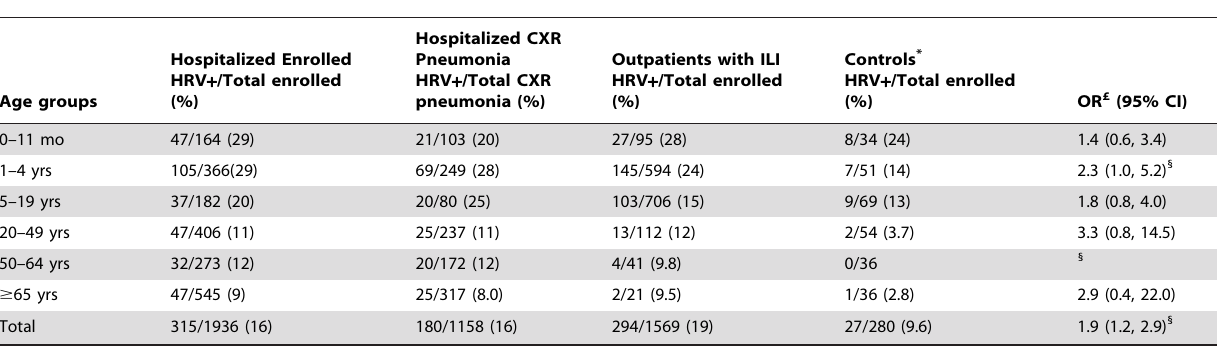
Table 1. Comparison of HRV detections among hospitalized patient with lower respiratory tract infections, outpatients with influenza-like illness and controls £ without respiratory symptoms and fever in the previous 3 days, Sa Kaeo Province, Thailand, September 1, 2003–August 31, 2005.